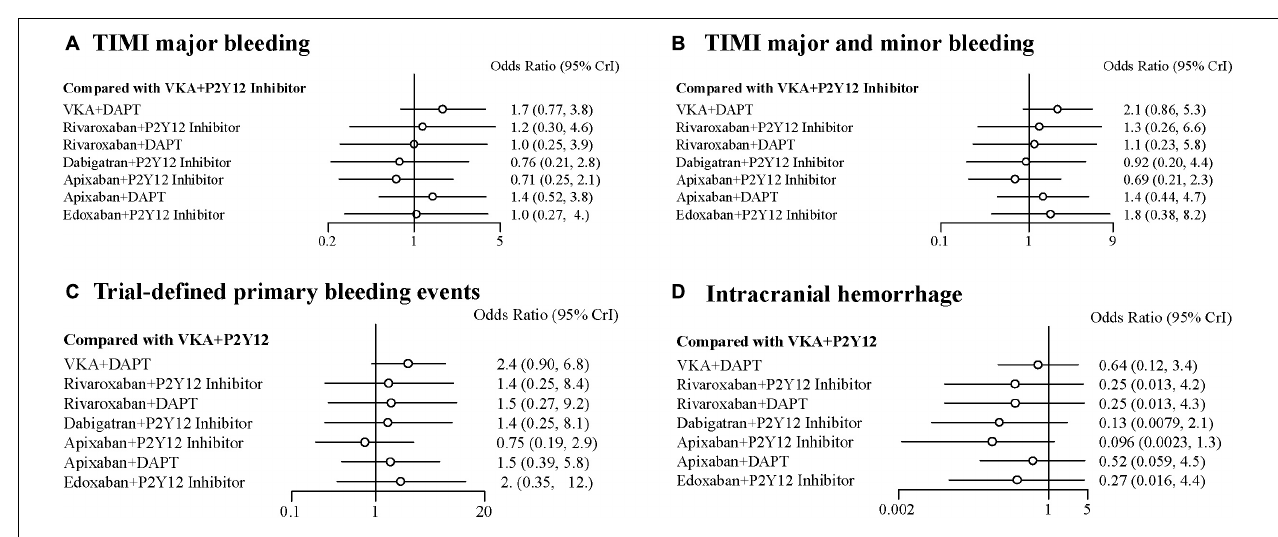
FIGURE 2 | Network of eight antithrombotic treatment regimens.